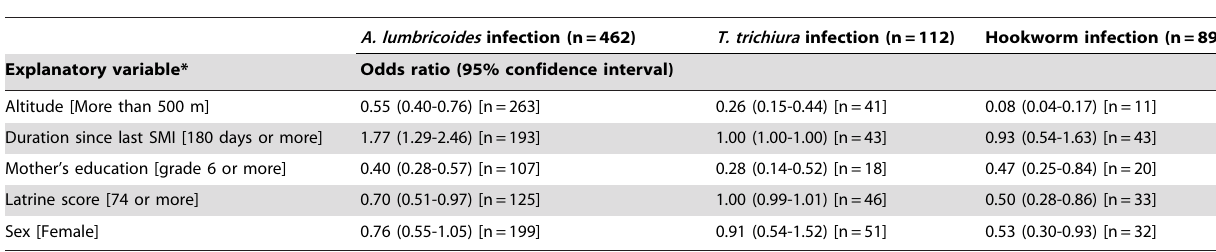
Table 3. Summary of multivariate analysis for risk of A. lumbricoides , T. trichiura and hookworm